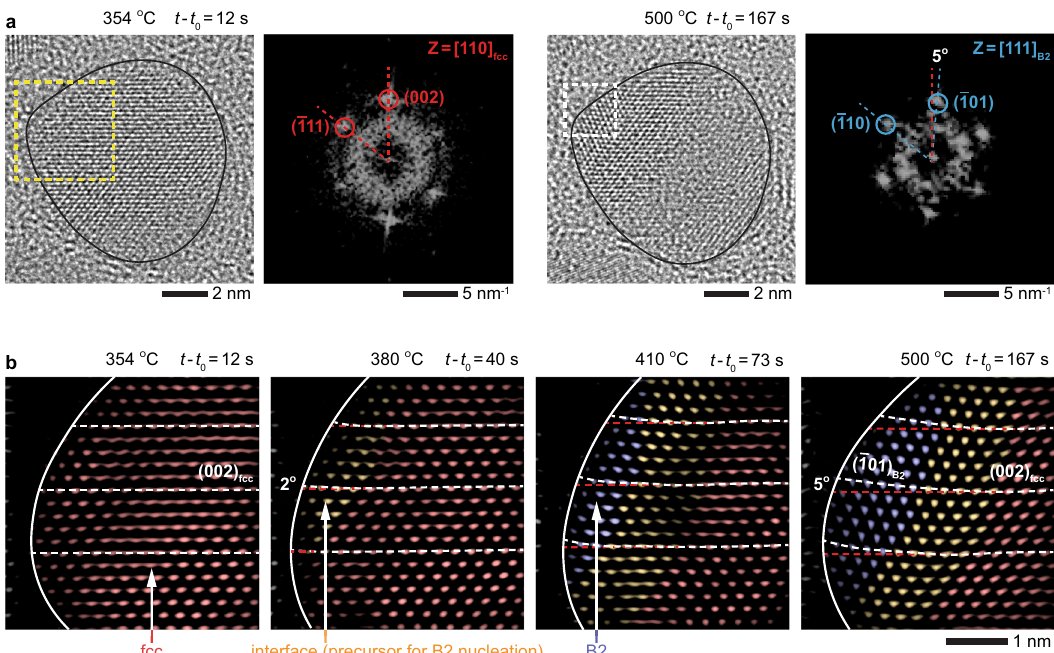
thatthenucleationoftheB2phasestartswiththeformationofaninterfaceregion, which acts as a precursor phase for the nucleation. The dashed white lines are (cid:1) (cid:3) guides showing the gradual bending of 002 ð Þ fcc planes into (cid:1) 101 B 2 planes as the B2 phase nucleates and grows. The dashed red lines are the 002 ð Þ fcc planes. t 0 is thetimepointatwhichwestartedincreasingthetemperaturefrom350to500°Cat a rate of 1°Cs − 1